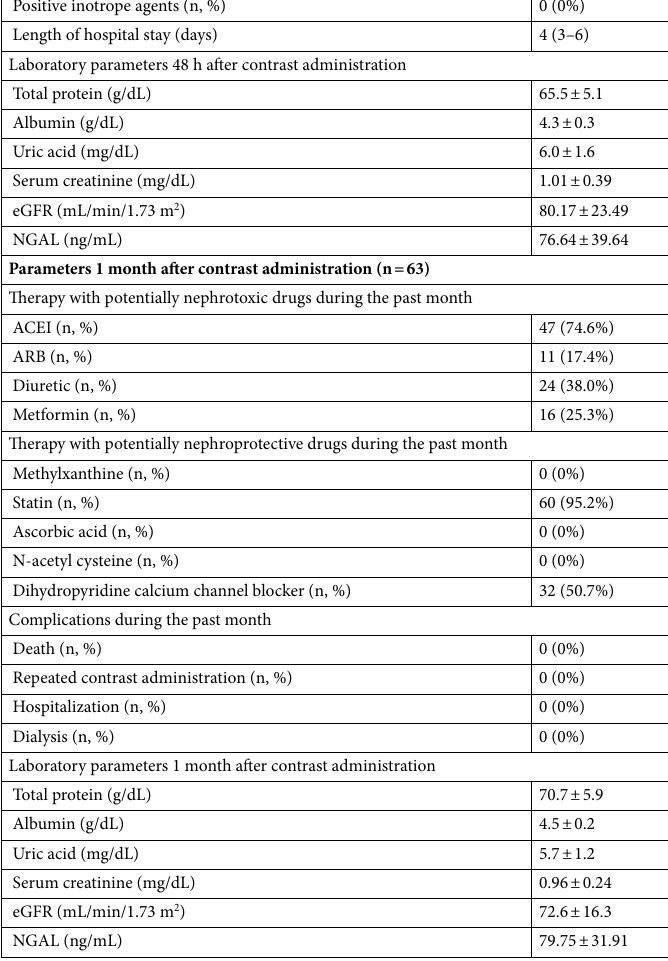
Table 1. Characteristics of patients included in the study. eGFR was calculated using the Modification of Diet in Renal Disease equation. Quantitative data are expressed as mean values ± standard deviation or median and interquartile range, as appropriate. Categorical data are expressed as number (percentage). ACEI angiotensin converting enzyme inhibitor, ARB angiotensin II receptor blocker, eGFR estimated glomerular filtration